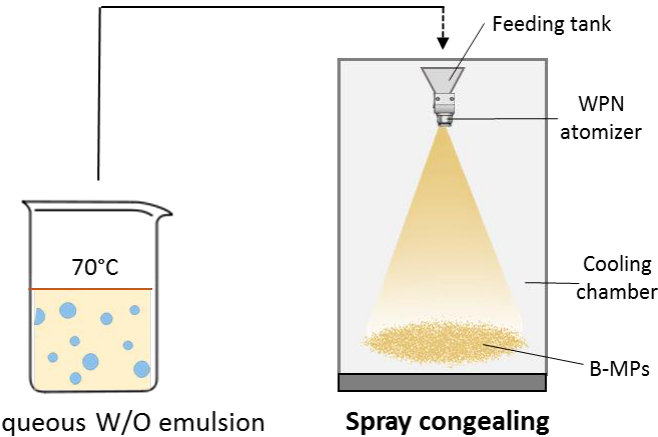
Figure 1. Schematic Illustration of the fabrication process of the b-MPs: Transformation of the non-aqueous emulsion into solid particles by spray congealing technology.